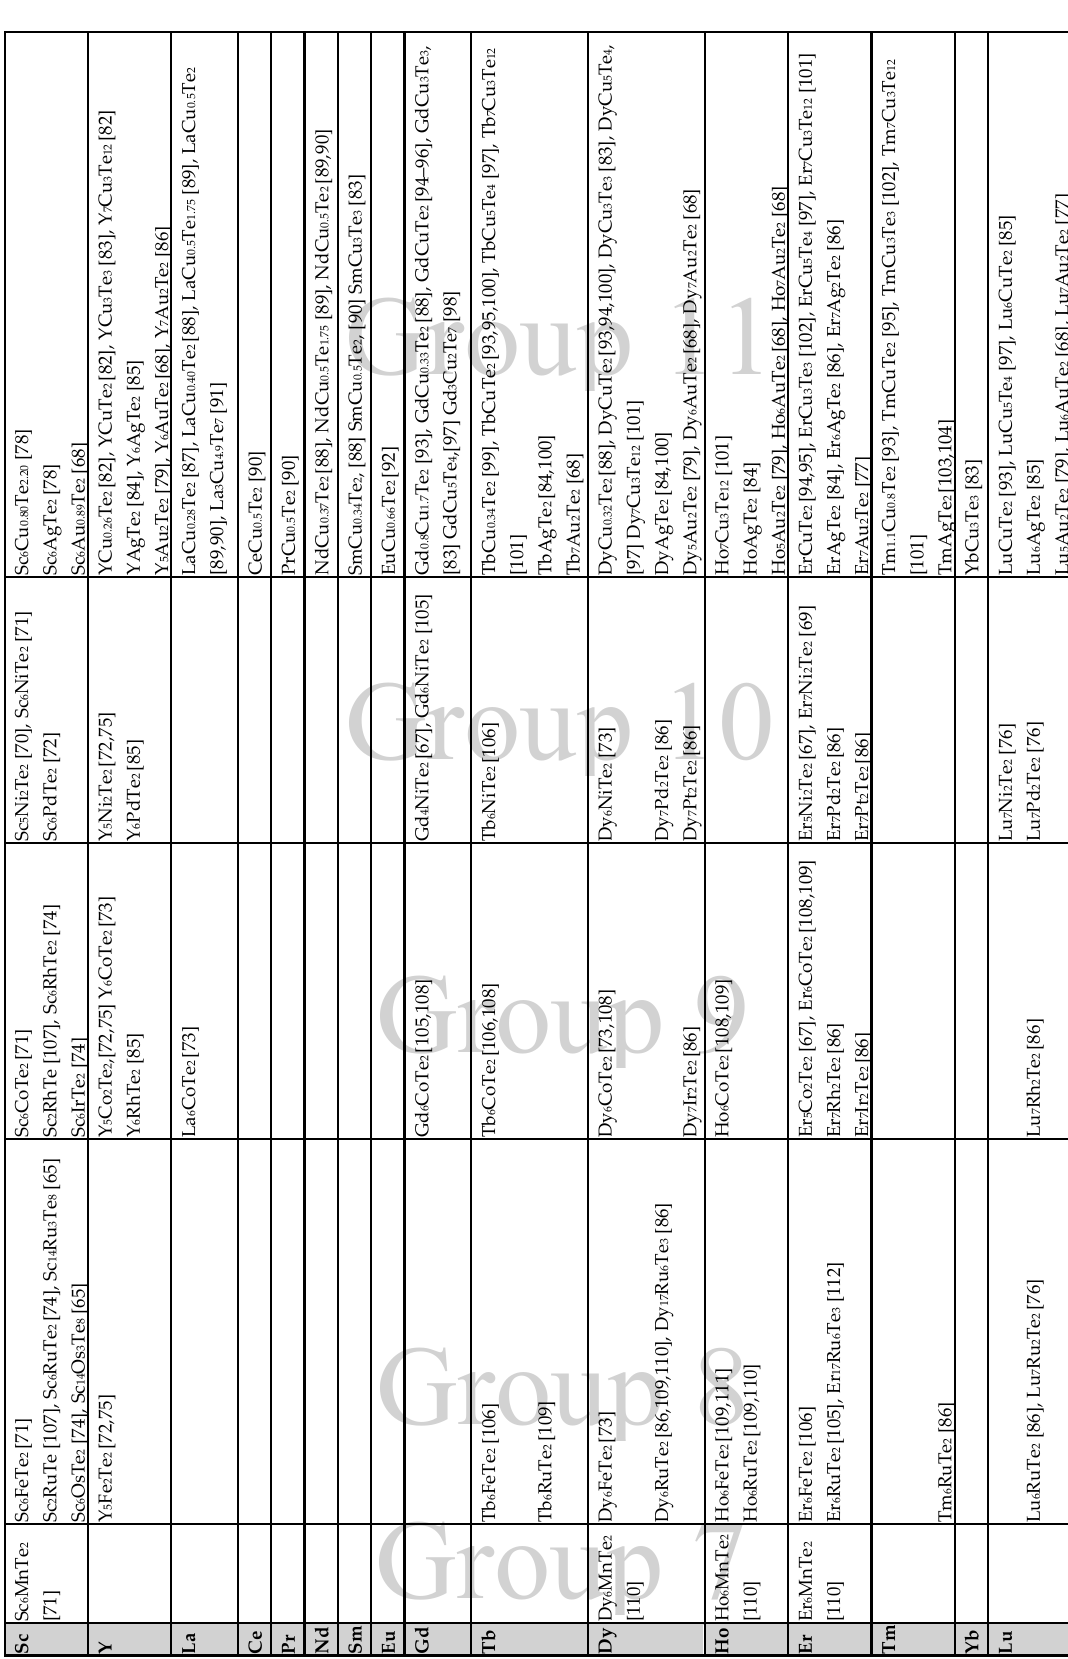
Table 3. Overview about the rare-earth transition-metal tellurides hitherto reported for the group seven to eleven elements. Crystals 2018 , 8 , x FOR PEER REVIEW 9 of